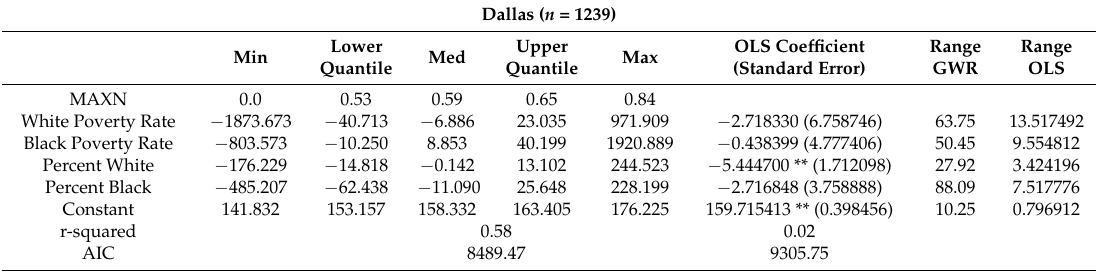
Table 9. Global and Local Parameter Estimates of the Geographically Weighted Regression Model for